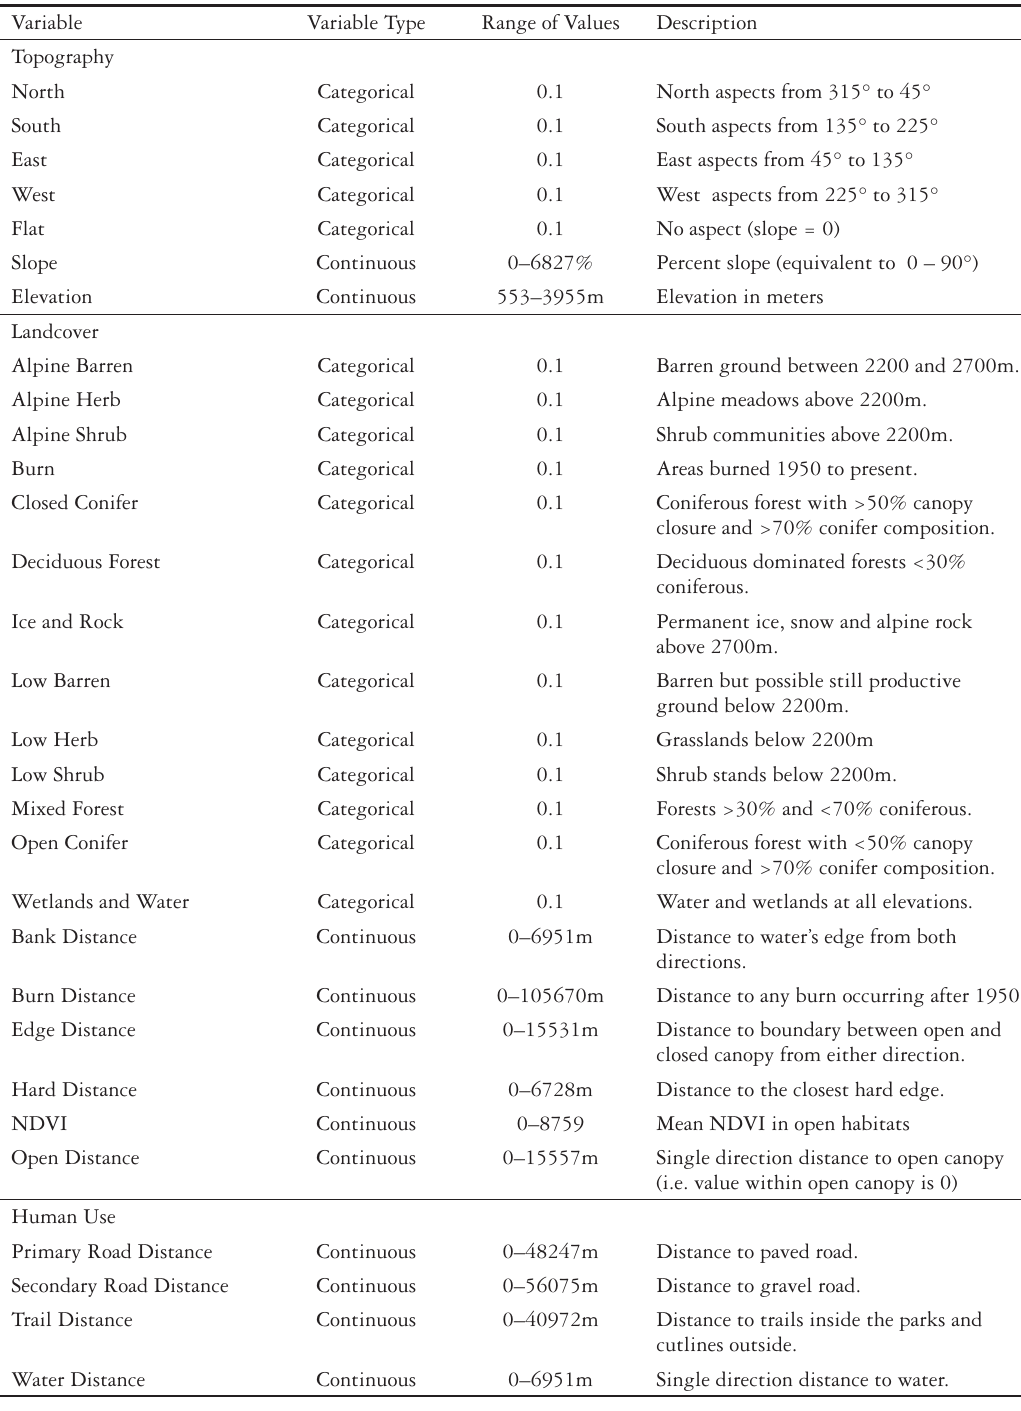
S-table 4. Terrain and landcover GIS layers (canidate variables) used in predictive RSF models for caribou and wolves, Banff and Jasper national